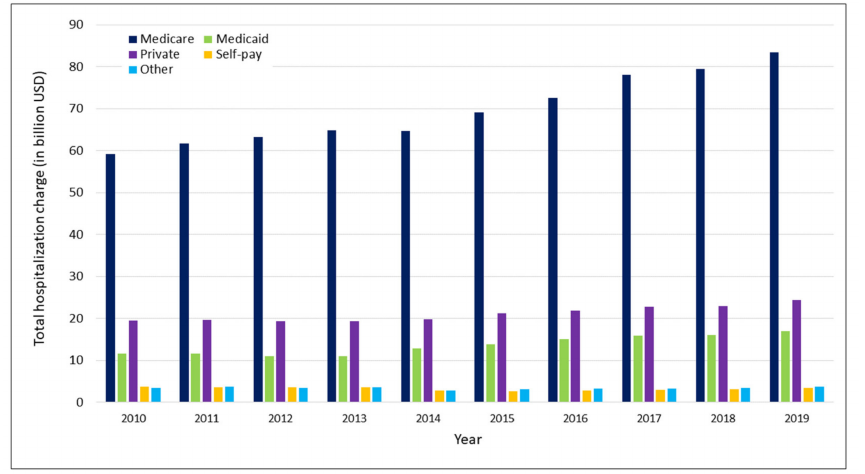
Figure 3. Trends in total diabetes associated hospitalization charges stratified by insurance